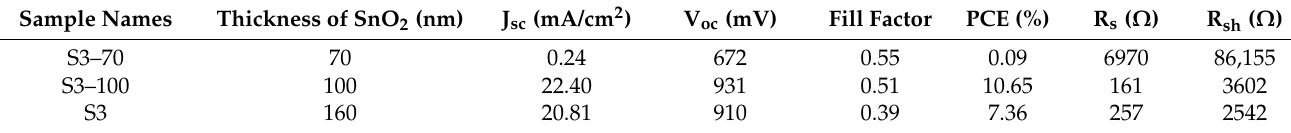
Figure S3: The J-V curve of PSCs with 500 ◦ C annealed SnO 2 with varied thickness, Table S1: The performance of PSCs with 500 ◦ C annealed SnO 2 with varied